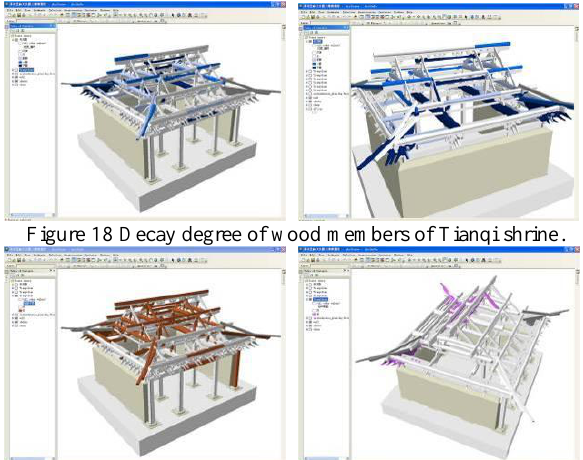
Figure 19 The wood members be intervened (left) and replaced (right) through Tianqi shrine